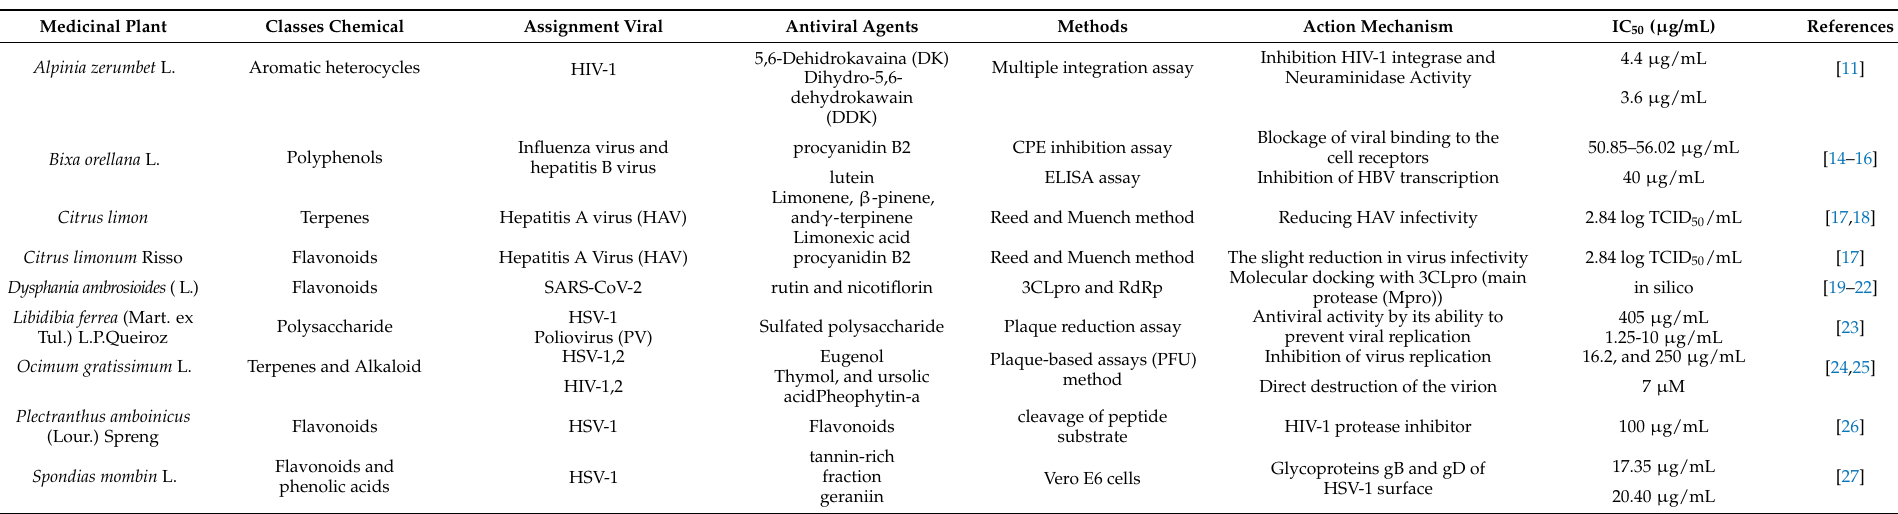
Table 2. Chemical components are probably involved in antiviral activities for main medicinal plants from Maraj ó